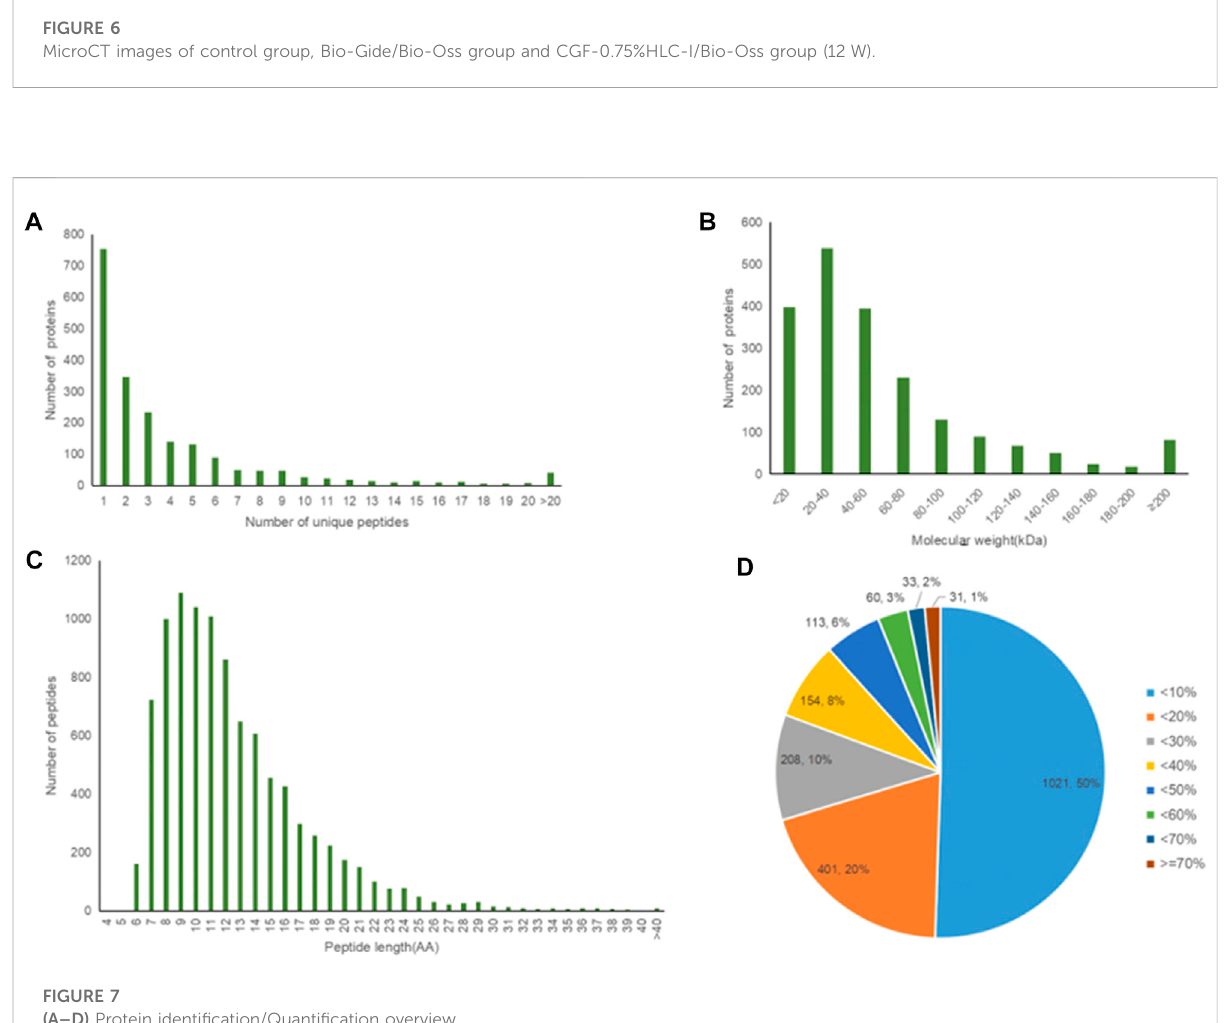
FIGURE 7 (A – D) Protein identi fi cation/Quanti fi cation